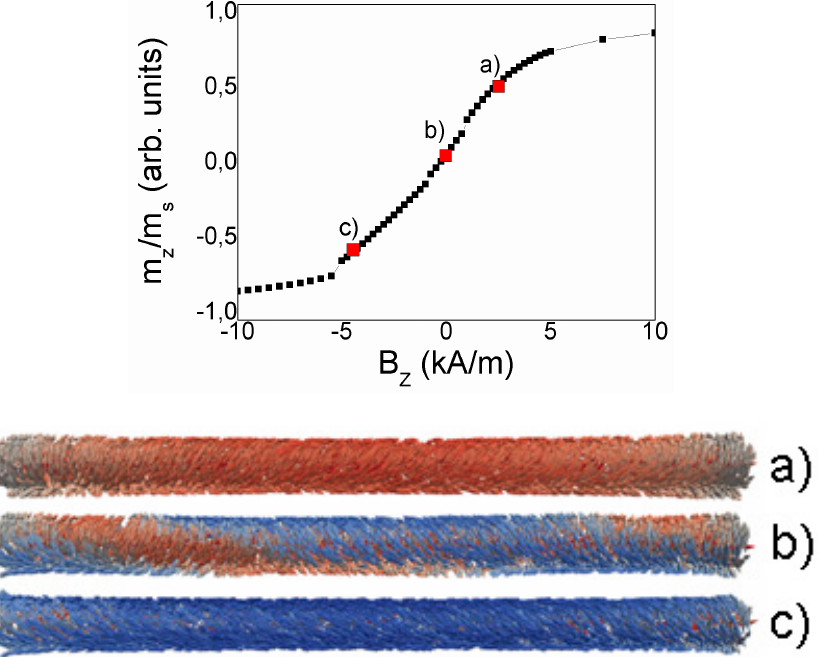
1 µ m diameter and 15 µ m length. Images ( a – c ) correspond to the points ( a – c ) in the hysteresis. Electric Figure 16. Calculated magnetization reversal curve and the images of spiral domains in cylinder current is 7 with 1 μ m diameter and 15 μ m length. Images ( a ), ( b ), ( c ) correspond to the points ( a ), ( b ), ( c ) in the hysteresis. Electric current is 7 mA.